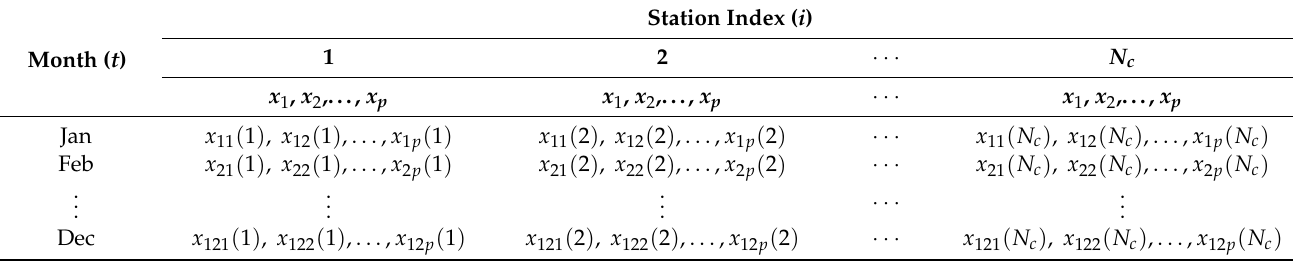
Table 2. Multivariate panel data format for temporal